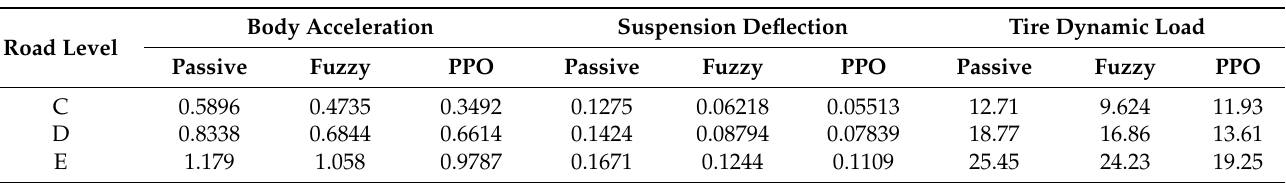
Figure 7. Simulation results of fuzzy, PPO, and passive suspension systems for a light vehicle on a D-class road. Table 6. The RMSE values of the two semi-active suspensions for a light vehicle under the same conditions.